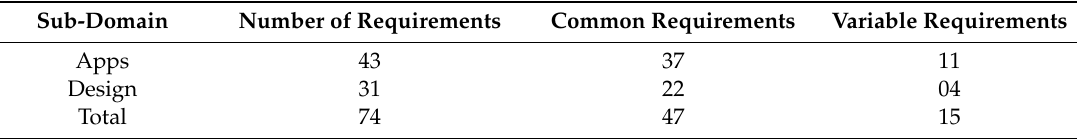
Table 7. Requirements elicitation by the traditional RE